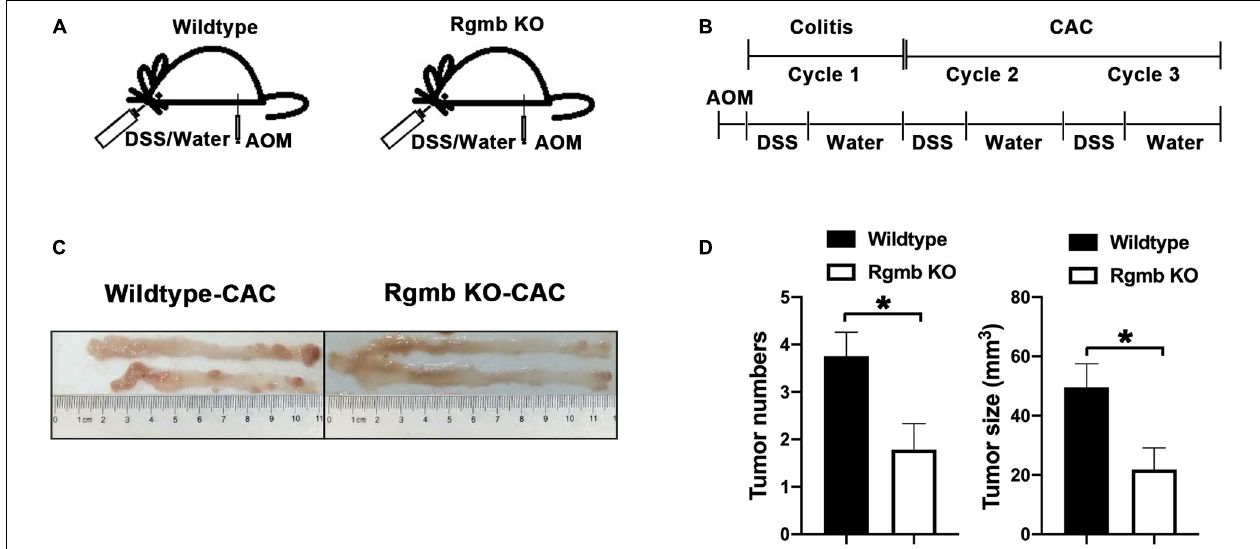
FIGURE 4 | Reduced CAC formation in Rgmb-deficient mice. (A,B) The schematic diagrams showing the protocol for induction of CAC in heterozygous global Rgmb-knockout (Rgmb ± ) and wildtype (Rgmb + / + ) mice. Cycle 1 represents the inflammatory stage before CAC formation. Cycle 2 represents the CAC formation stage following inflammatory conditions. (C) Macroscopic images of the AOM/DSS-induced tumors in Rgmb-knockout mice and wildtype littermates. (D) The histograms of tumor number and size of CAC tissues. n = 9 and * P <